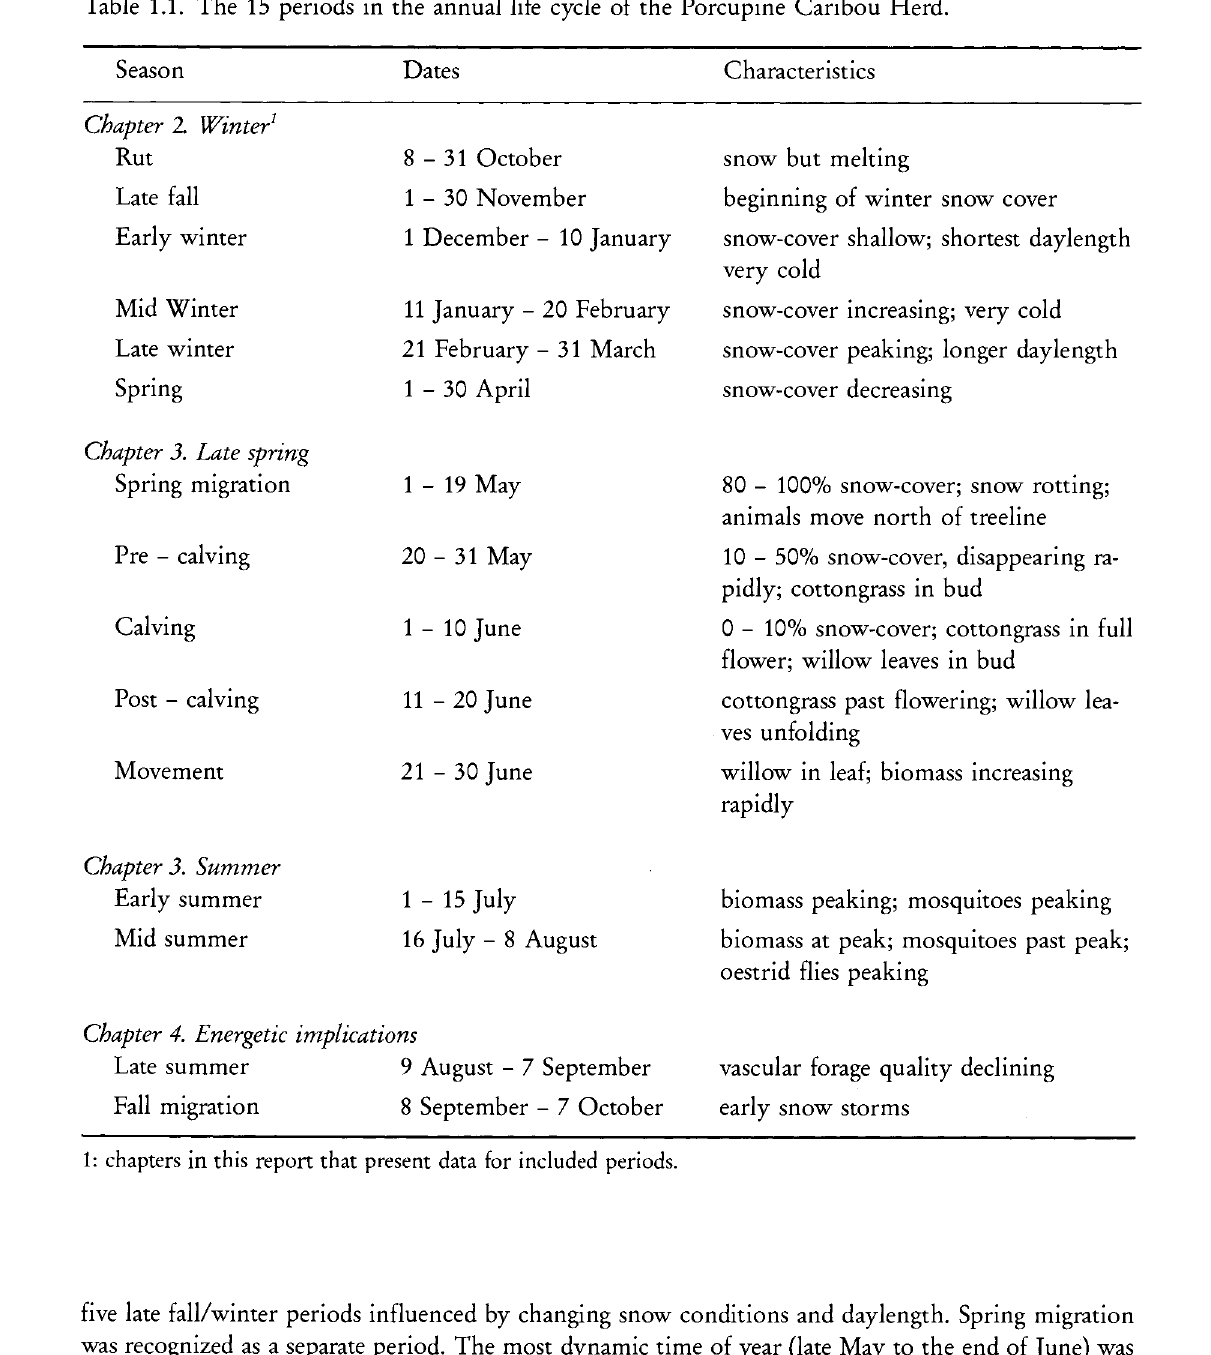
Table 1.1. The 15 periods in the annual life cycle of the Porcupine Caribou Herd.